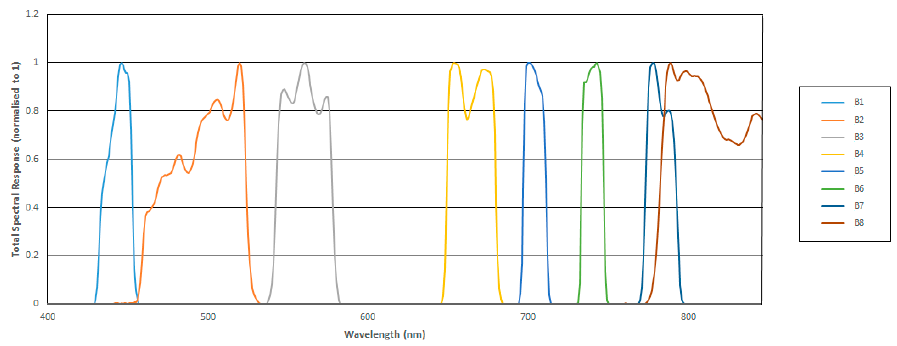
Figure 11. Sentinel-2A spectral response (bands 1–8).